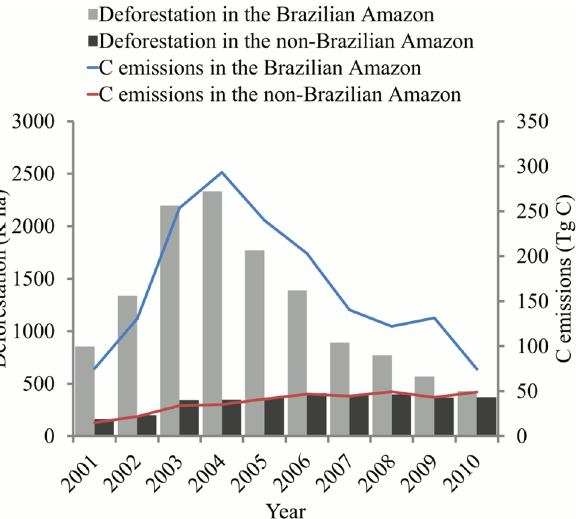
Fig 7. Annual deforestation and associated carbon emissions in the Brazilian and non-Brazilian